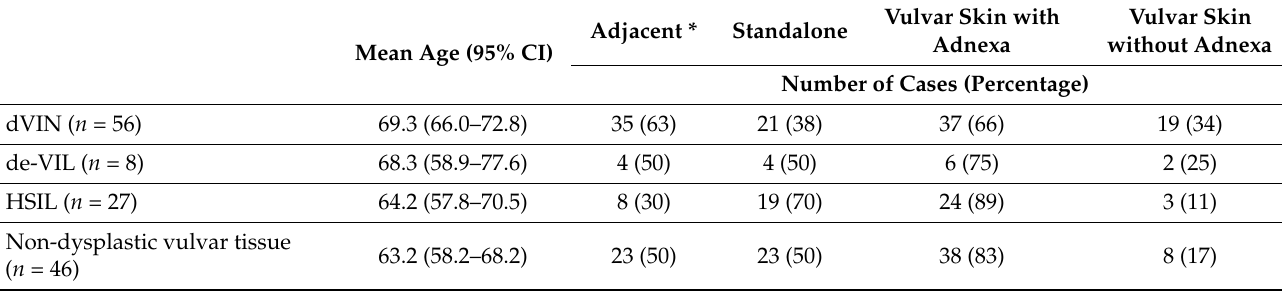
Table 1. Clinico-pathological